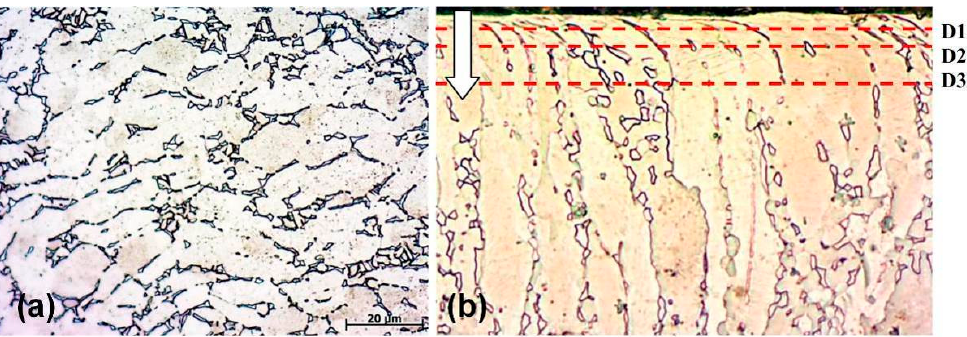
Figure 1. Microstructure of Ti-6Al-4V ( a ) and subsurface deformation regions ( b ) after dry machining of Ti-6Al-4V: D1 (highly deformed region), D2 (moderate deformation) and D3 (unaffected grains), data from [12].